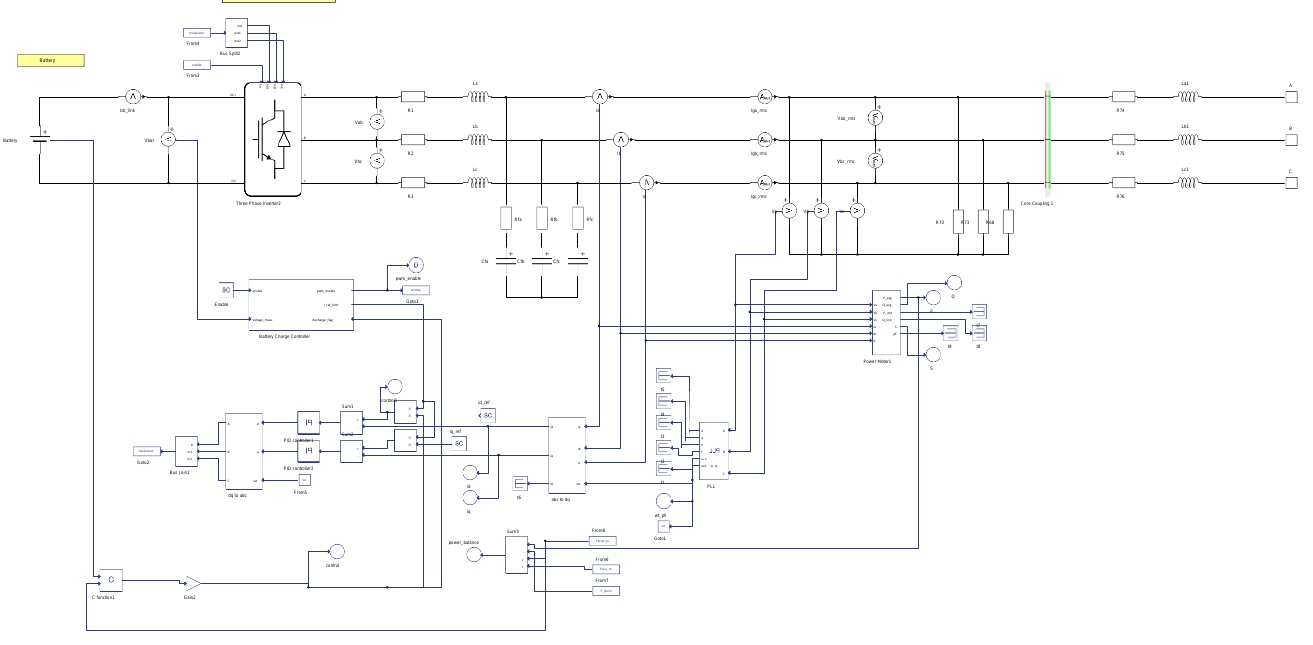
Figure 3. Block diagram of battery storage system.